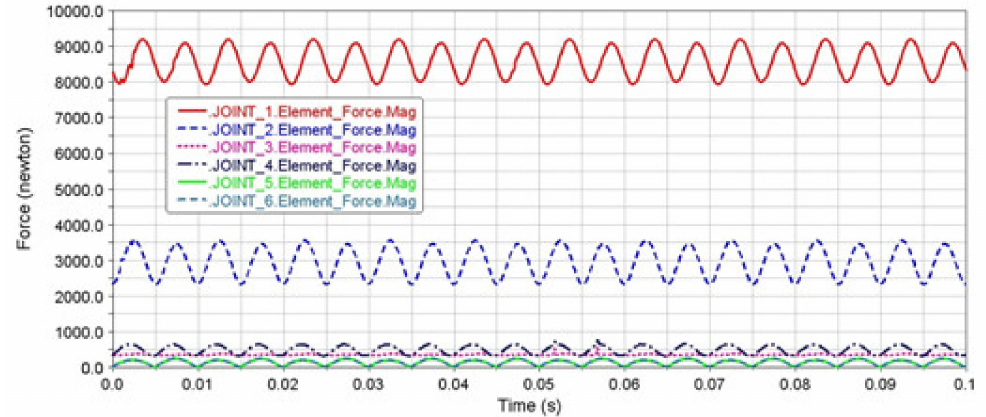
Figure 7. The performance of the dynamic forces in the joints of the mechanism at the deviation of the eccentric system e = 2 mm and frequency of 100